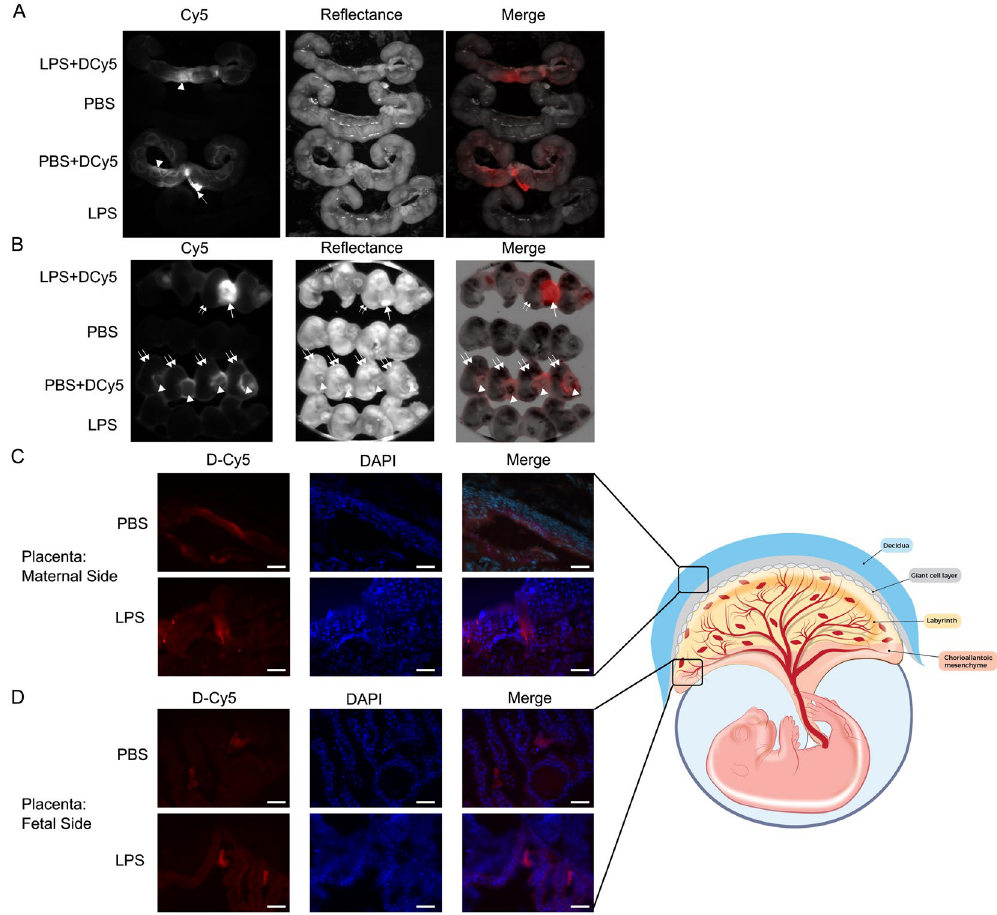
Figure 1. Ex vivo fluorescent imaging and immunohistochemistry to monitor trafficking of Cy5-labeled dendrimer (DCy5). On gestational day 17 (E17), pregnant CD-1 dams were given intrauterine injections of LPS or PBS. DCy5 (10 mg/kg) was administered intraperitoneally 1 hour later. After 6 hours, uterus and embryos were isolated, imaged to monitor the fluorescent signal from DCy5, and prepared for histochemical verification. ( A ) The labeled dendrimer accumulated at LPS injected surrounding structure (arrow heads) and in the bladder (arrow). ( B ) Four embryos from each uterus were imaged. The outer embryos are from opposing distal ends of the uterine horns, and the two embryos in the center were taken from either side of the LPS or PBS injection site. The labeled dendrimer was distributed evenly in placentas (arrowheads) from proximal and distal embryos in the PBS group, but had increased accumulation in placentas of embryos near the site of LPS injection (arrow). ( C ) Histochemistry confirmed the presence of DCy5 in the maternal side of the placenta. ( D ) DCy5 was present in the fetal tissue of the placenta, but was restricted to the yolk sac membranes. The presence of DCy5 in the yolk sac increased with LPS exposure. Images are 40 × magnifications, and scale bars represent 50 μ m. Double arrows: embryo. The diagram was printed with permission © 2016 Jennifer Fairman, CMI, Johns Hopkins University